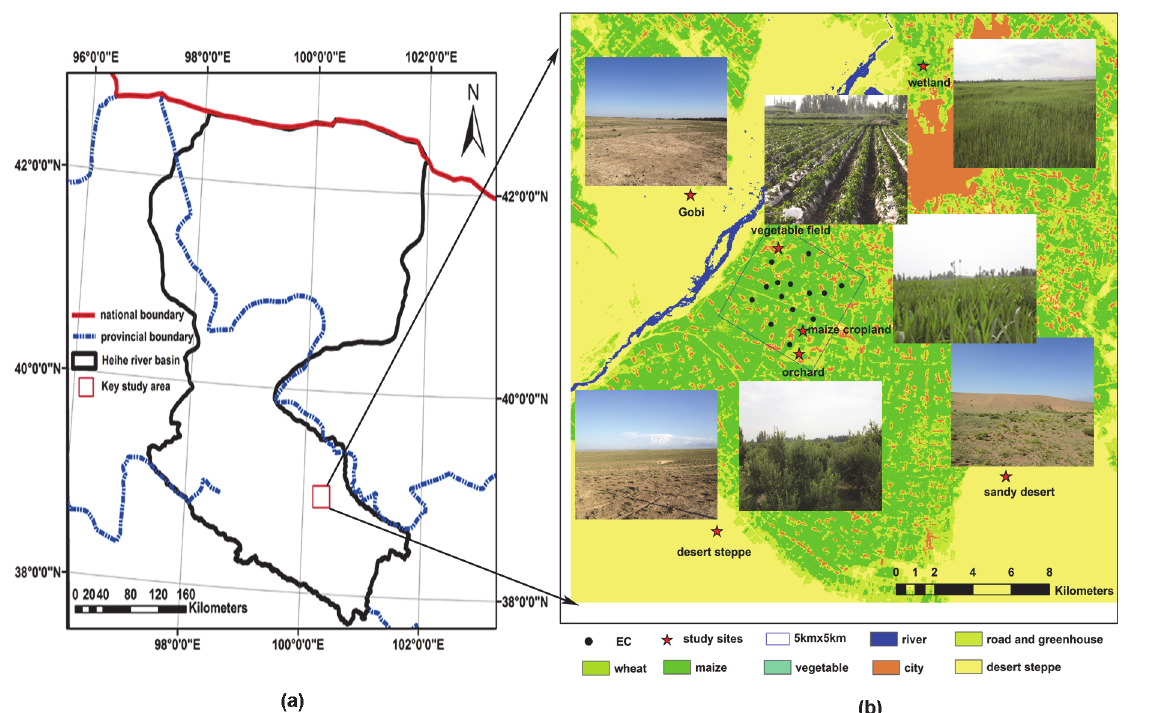
Fig 1. The distribution of the eddy covariance in different